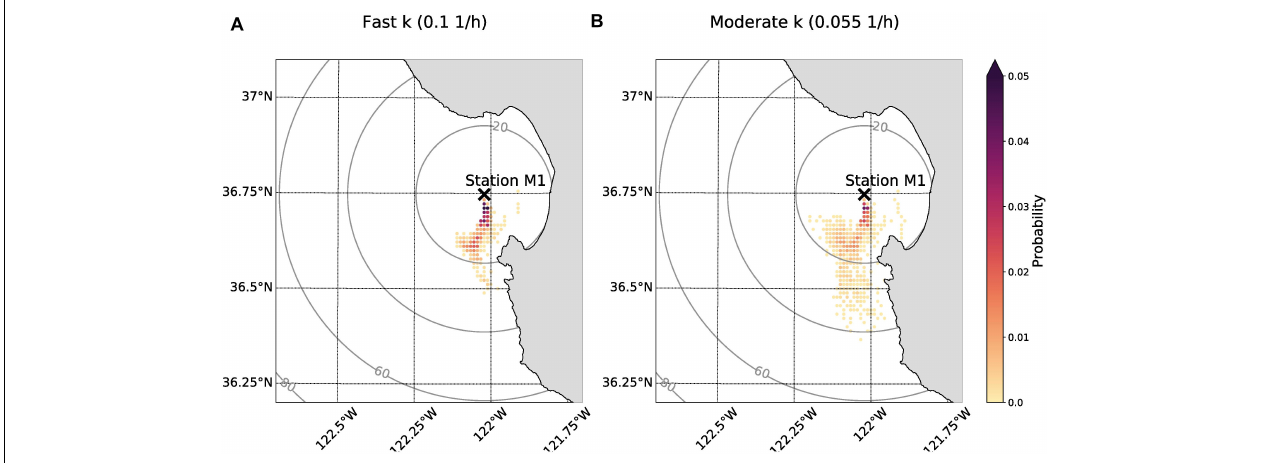
FIGURE 6 | Probability maps showing anchovy eDNA origin given field sample detection on 29 September 2015. The sampling location (Station M1) is indicated with black “X.” The color corresponds to the probability that eDNA originated in that cell. The rings indicate distance from Station M1 in units of km. (A) Origin location probabilities of eDNA if the decay rate constant was fast (0.1 h − 1 ). (B) Origin location probabilities of eDNA if the decay rate constant was moderate (0.055 h − 1 ). The sum of all probabilities for each panel is equal to